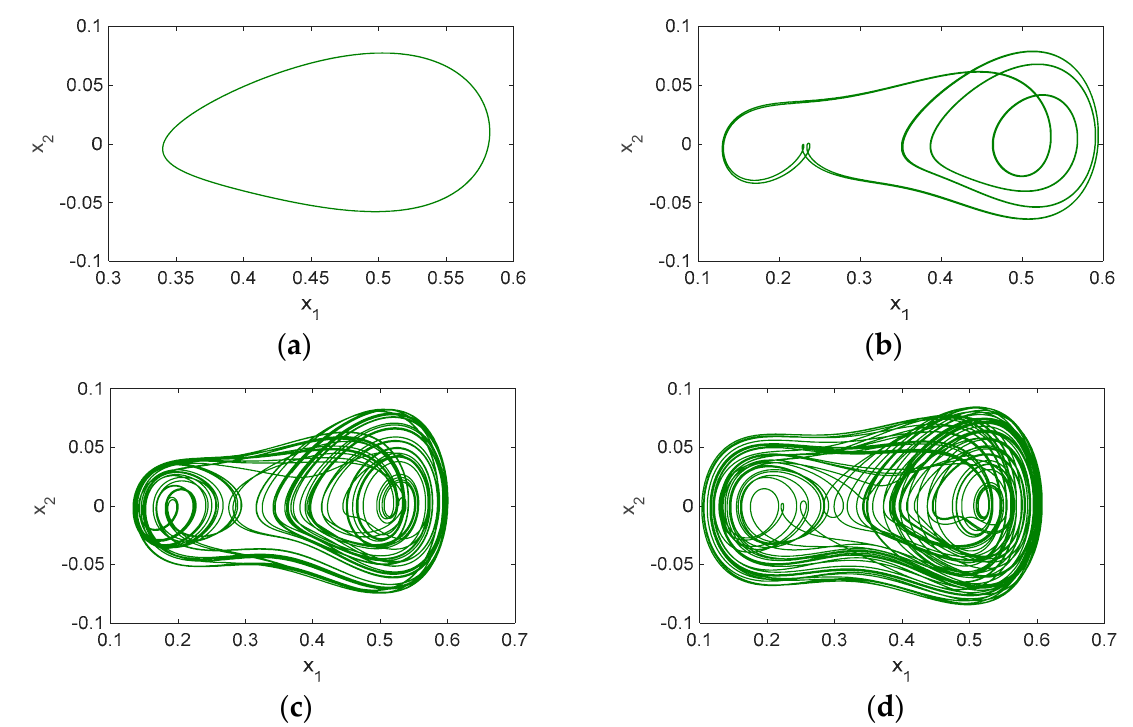
Figure 3. Phase portrait of MEMS resonator when R = 0.02 generated with initial conditions ( 0,0 ) when ( a ) α ( t ) = α ( t ) = 0.93, ( b ) α ( t ) = α ( t ) = 0.95, ( c ) α ( t ) = α ( t ) = 0.97, and ( d ) α 1 ( t ) = α 2 ( t ) = 0.99.